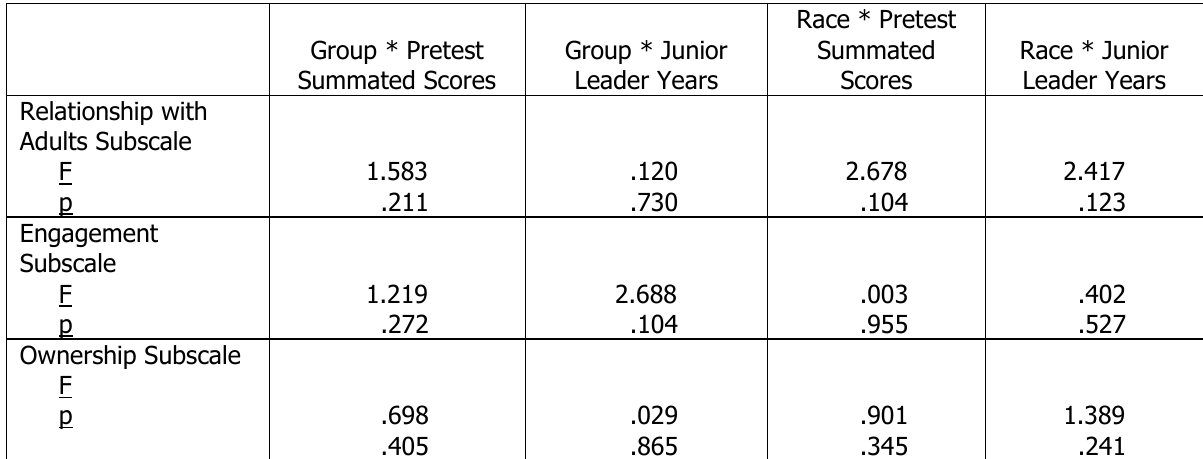
Interaction Terms F Statistics and Significance